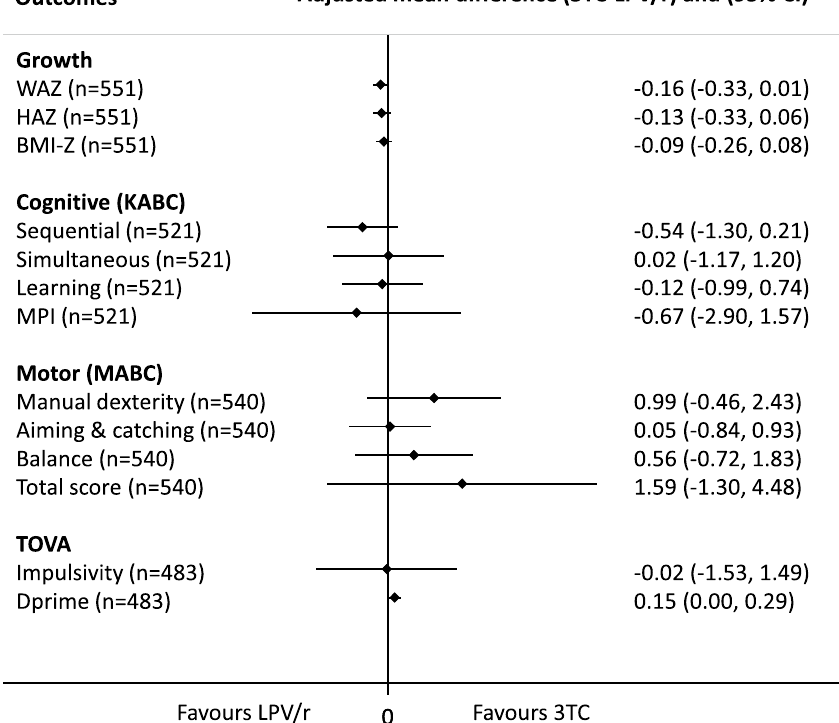
Figure 2. Comparison of growth, neuro-psychological and clinical outcomes by treatment groups. Note: Estimates were adjusted for country, socio-economic level of the caregiver, number of children below 5 years of age in the household, education level and ability to read of the caregiver, gender and age of the child and treatment duration. Inverse probability weighting was applied to account for selection bias. LPV/r lopinavir- ritonavir, 3TC lamivudine, CI confidence interval, SDQ strengths and difficulties questionnaire, WAZ weight- for-age z-score, LAZ length-for-age z-score, BMI-z body mass index z-score, KABC Kaufman Assessment Battery for children, MPI mental processing index, MABC Movement Assessment Battery for Children, TOVA test of variables of attention. DPrime is an overall measure of